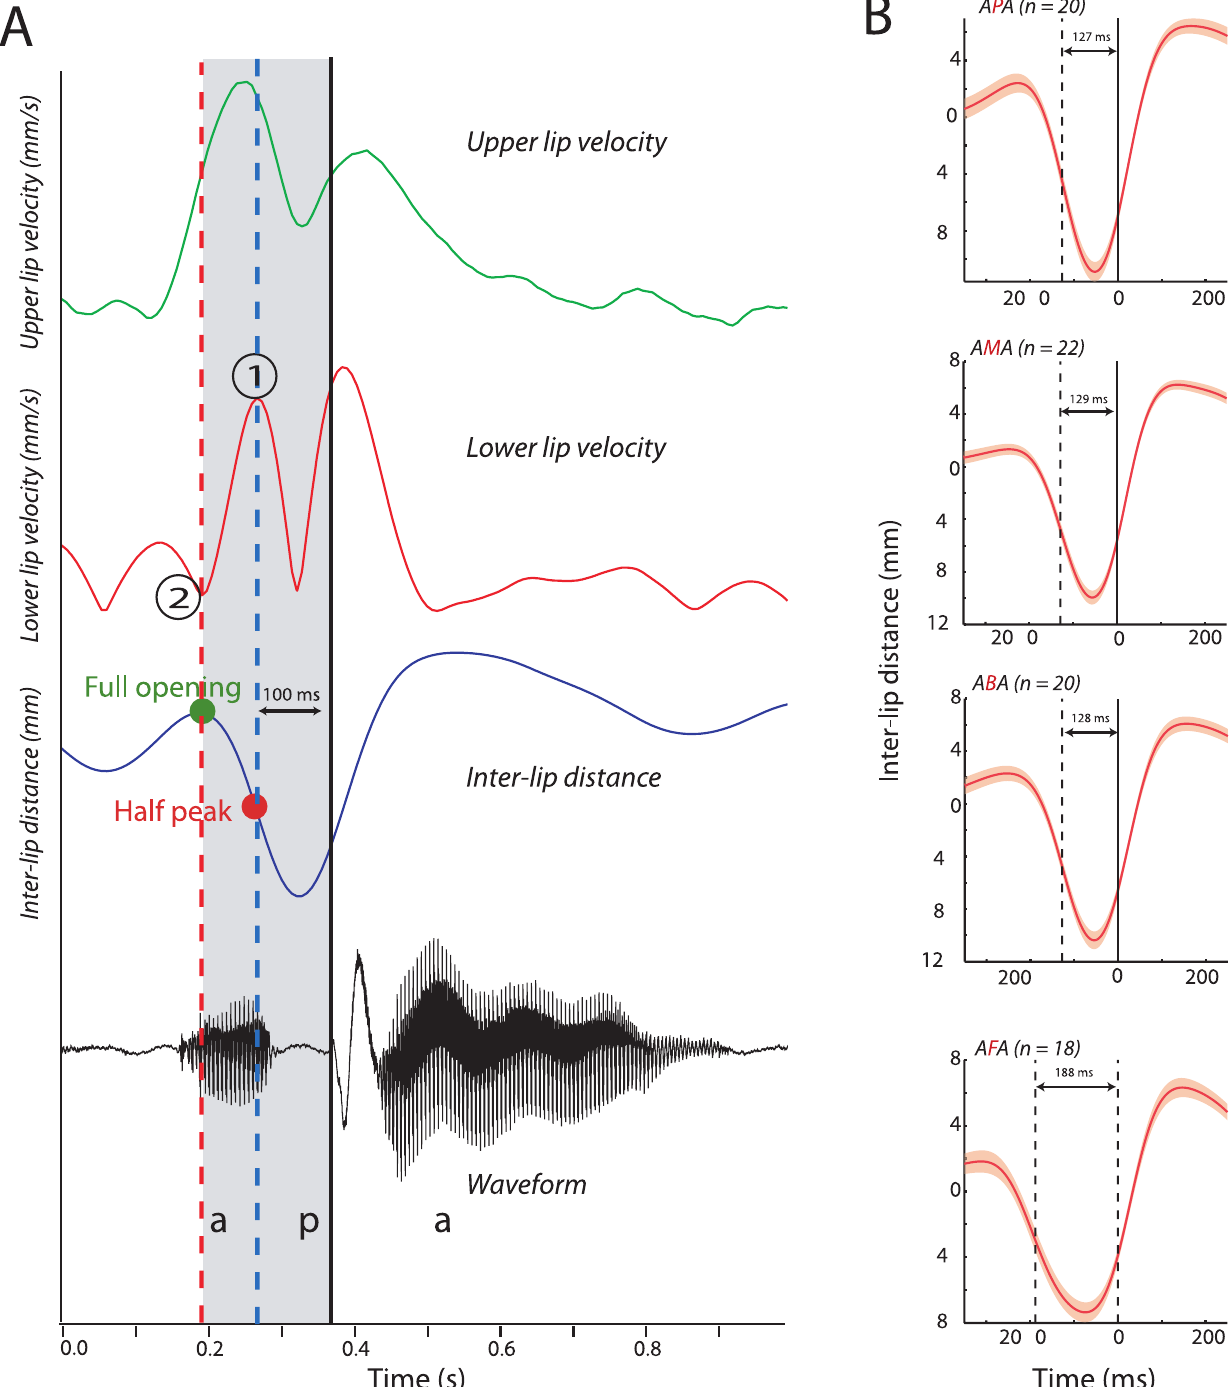
Figure 9. Context modifies time-to-voice for consonants. A - Visual and auditory dynamics during the production of the word ‘‘APA’’ by a single speaker. Conventions as in Figure 8A. B - Average inter-lip distance as a function of time for the word APA, AMA, ABA and AFA across all subjects in the database aligned to the onset of the respective consonants (/p/, /m/, /b/, /f/). X-axes depict time in milliseconds, y-axes depict the mean corrected inter-lip distance in mm. Shaded regions denote the standard error of the